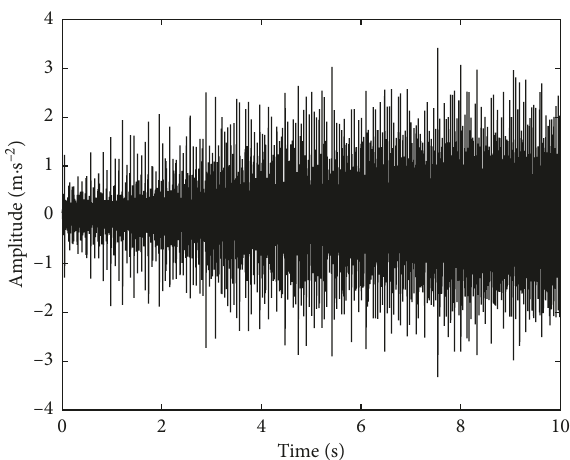
Figure 19: Waveform of rolling bearing